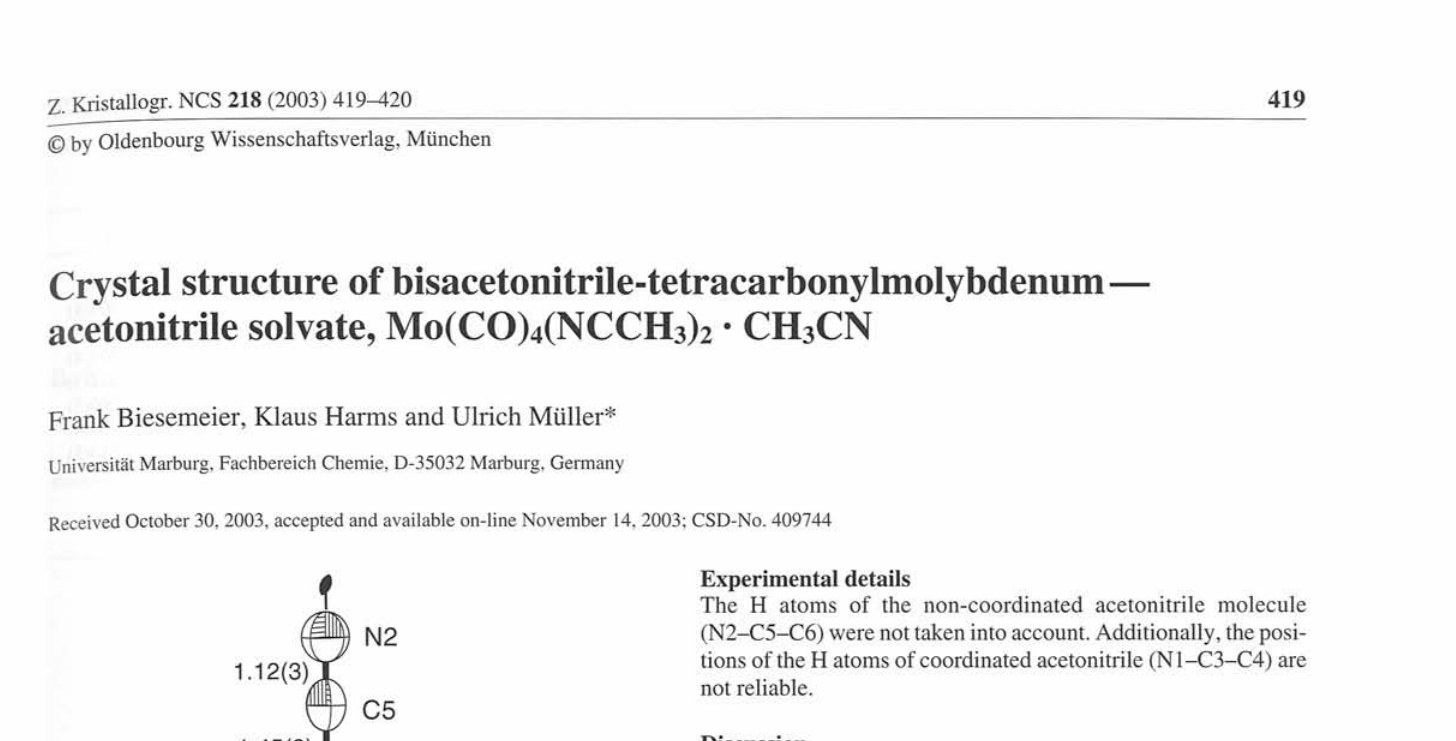
Table 1. Data collection and handling.